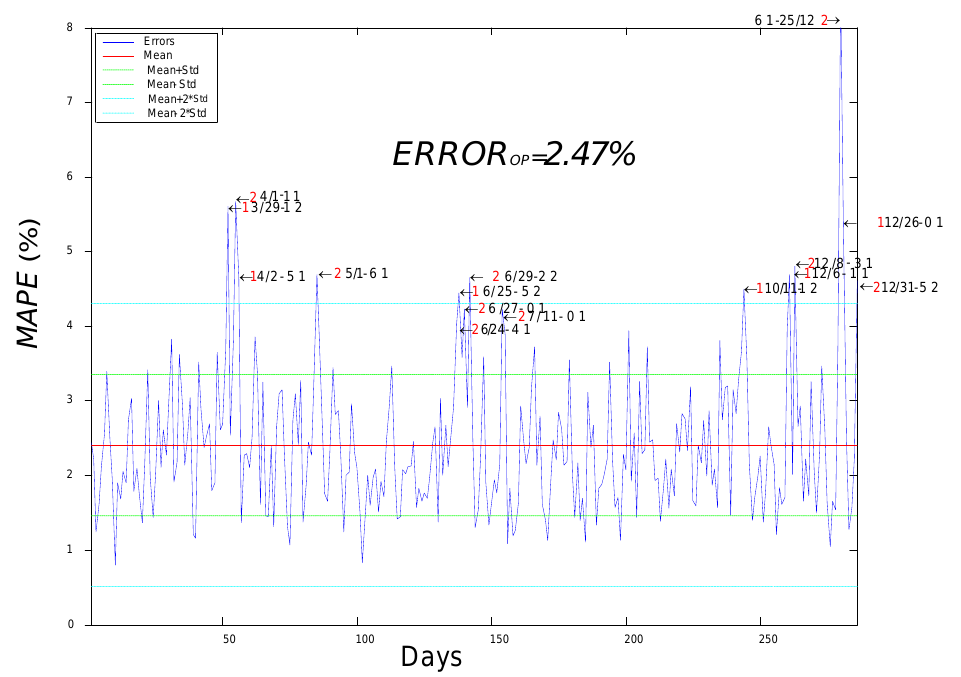
Figure 7. Errors per day (without bad measures). In the x-axis are the days. In the y-axis are the errors by Equation